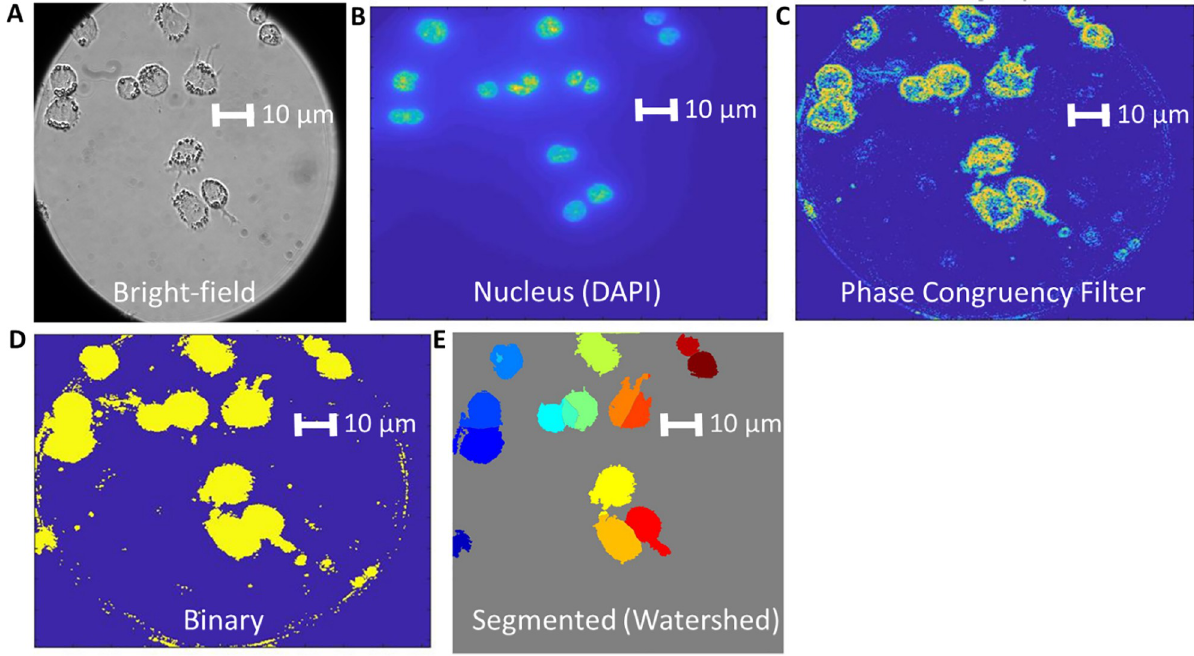
Fig 1. Automated cell segmentation process. The bright-field image (A) and nucleus data from a DAPI stain (B) are utilized to segment the cells. The combination of the DAPI data, the smFISH channel, and the phase congruency filtered bright field data (C) are utilized to create a binary image (D). A watershed from the nucleus data and the binary image are utilized to create the final segmented image (E).